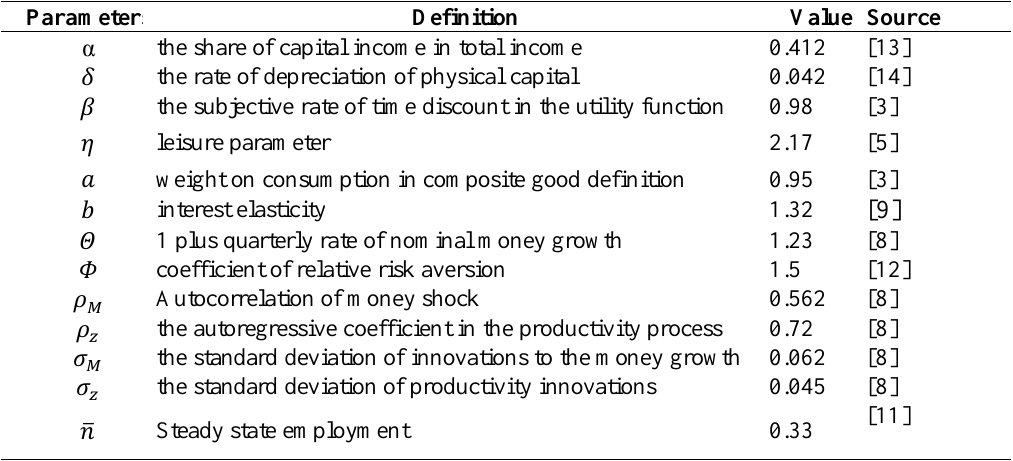
Table 1. Baseline Parameter Values